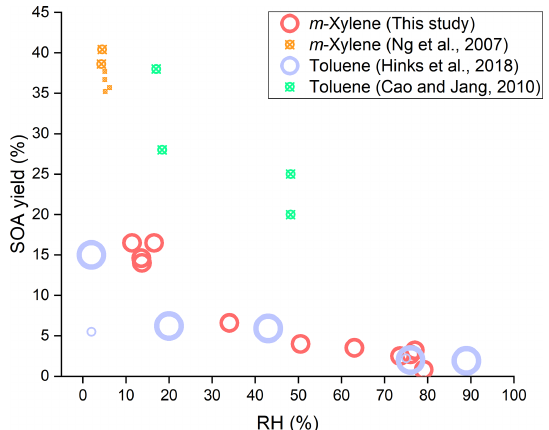
Figure 2. SOA yields as a function of RH for different aromatic (toluene and m -xylene) oxidation under low-NO x conditions with photolysis of H 2 O 2 as the OH source. The hollow circles represent where no seed particles were introduced and the circles with a cross where seed particles were introduced. The size of markers indicates the magnitude of the amount of reacted